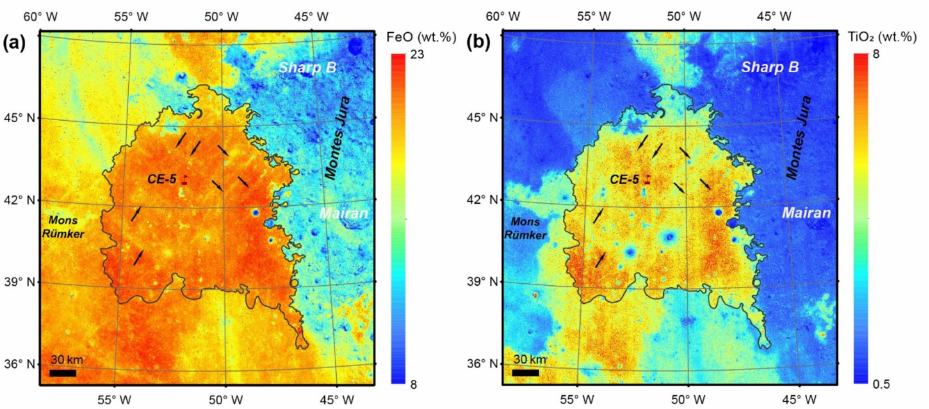
Figure 2. FeO ( a ) and TiO 2 ( b ) abundances of the Em4 unit. The red flag marks the CE-5 landing site. The dark grey line denotes the geologic boundary of Em4. The arrow denotes the external ejecta from different